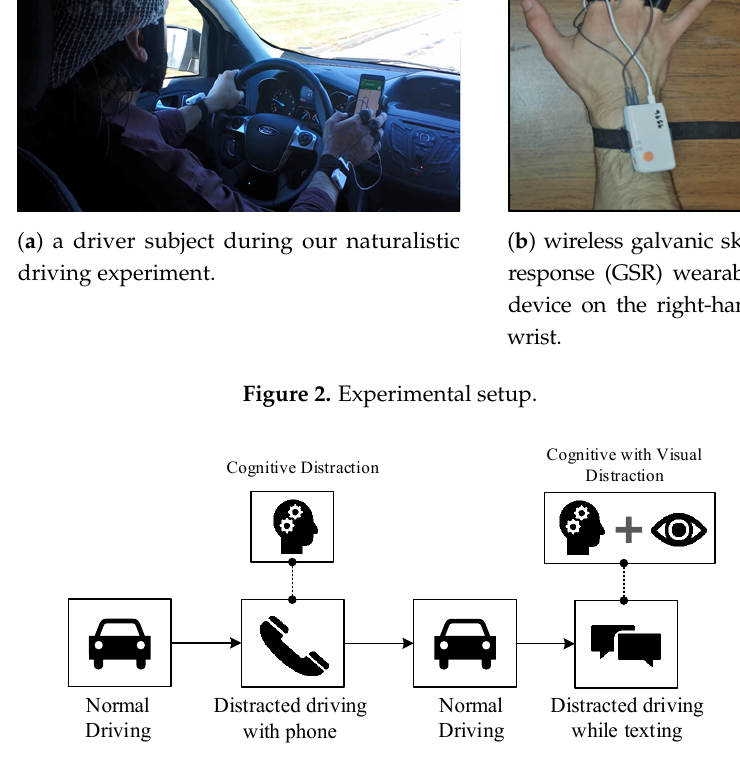
Figure 3. Illustrates data collection order during our naturalistic driving